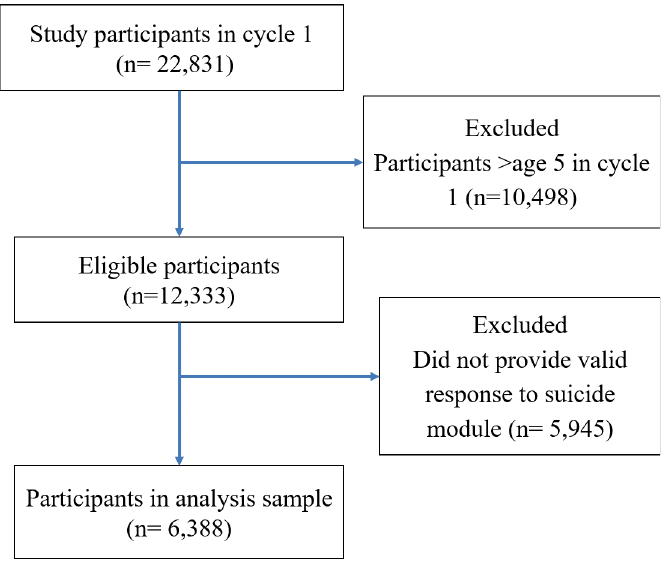
Fig 1. Study population and analysis cohort, NLSCY CONSORT flow diagram, Canada, 1994–2009.